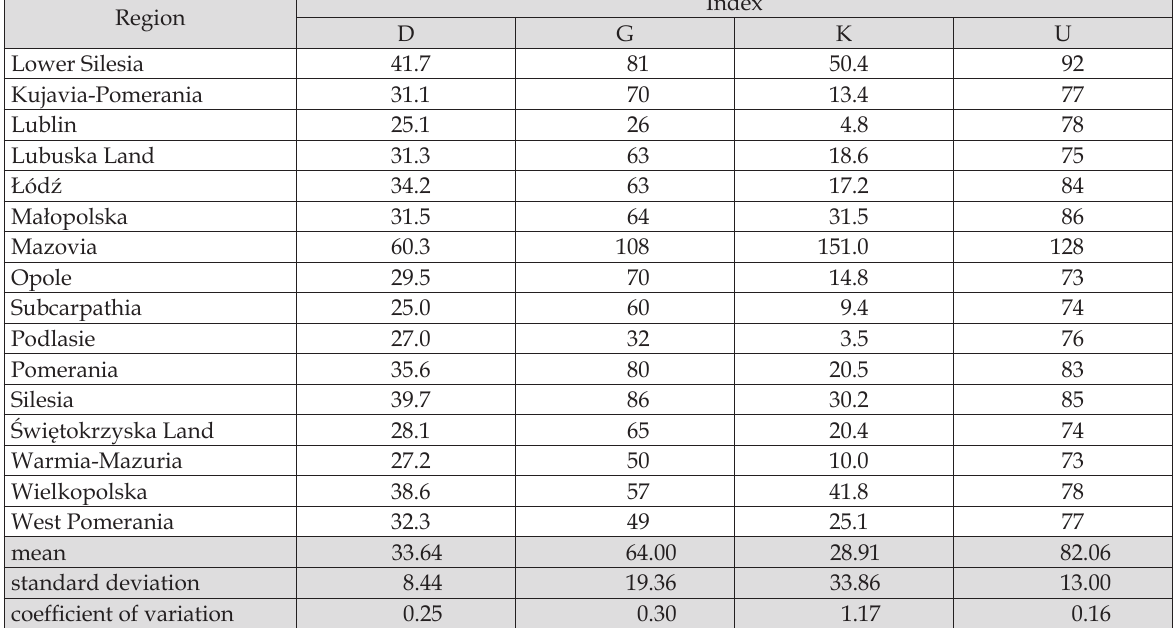
Table 6. Socio-economic indices in